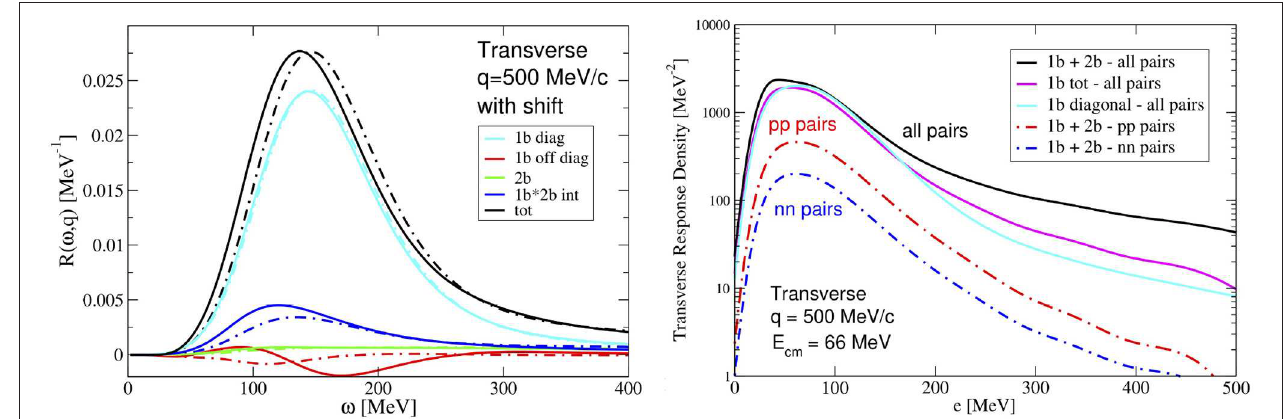
FIGURE 6 | (Left) Transverse electromagnetic response of 4 He at | q | = 500 MeV without (dashed lines) and with (solid lines) interacting two-nucleons in the final state. The different contributions corresponding to one-body current diagonal terms, one-body current off-diagonal terms, interference between one- and two-body currents, and two-body currents only are separately shown. (Right) Transverse response densities of 4 He at | q | = 500 MeV and final center of mass energy E cm = | q | 2 / (2 m N ). The solid cyan and magenta solid line display the diagonal only and diagonal plus off-diagonal one-body term, respectively. The solid black curve corresponds to the total one- plus two-body current result while in the blue dashed and red dashed isolate the contribution of the nn and pp pairs is singled-out. Figure adapted from Pastore et al.